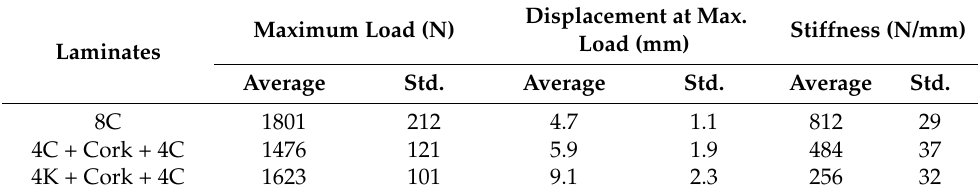
Table 3. Cork core effect and hybridization effect on the compressive